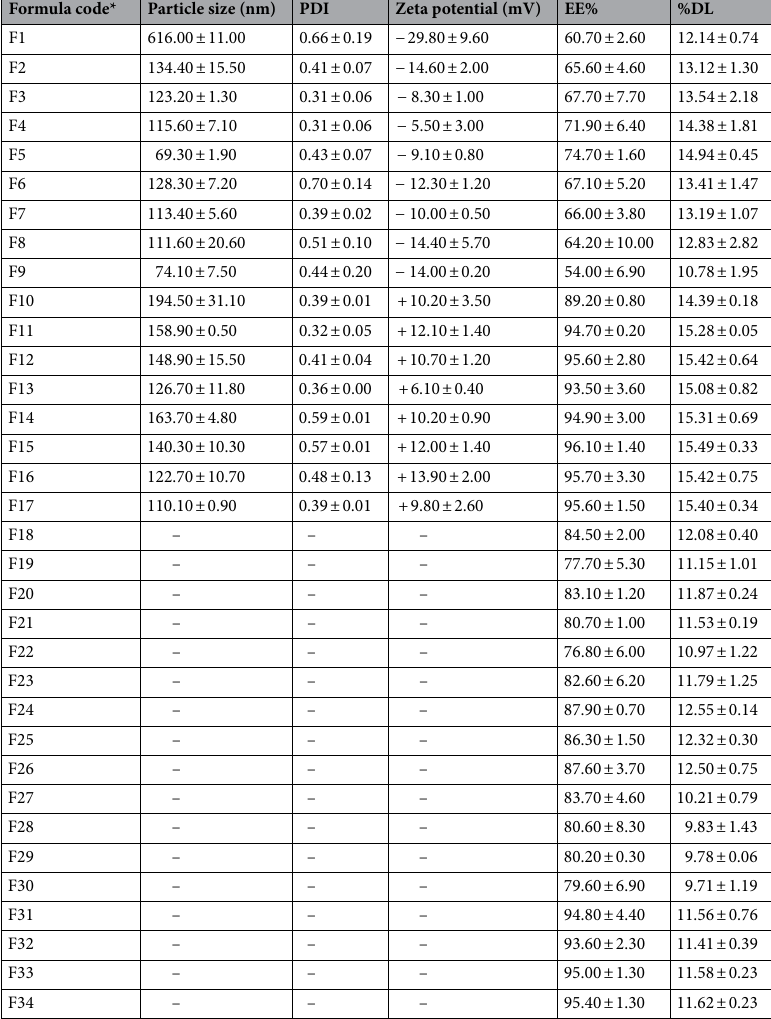
Table 2. Properties of nobiletin-loaded vesicular systems. *The particle size of cerosomes (F18–F34) was not determined owing to the fact that cerosomes are not spherical vesicles but have tubular like